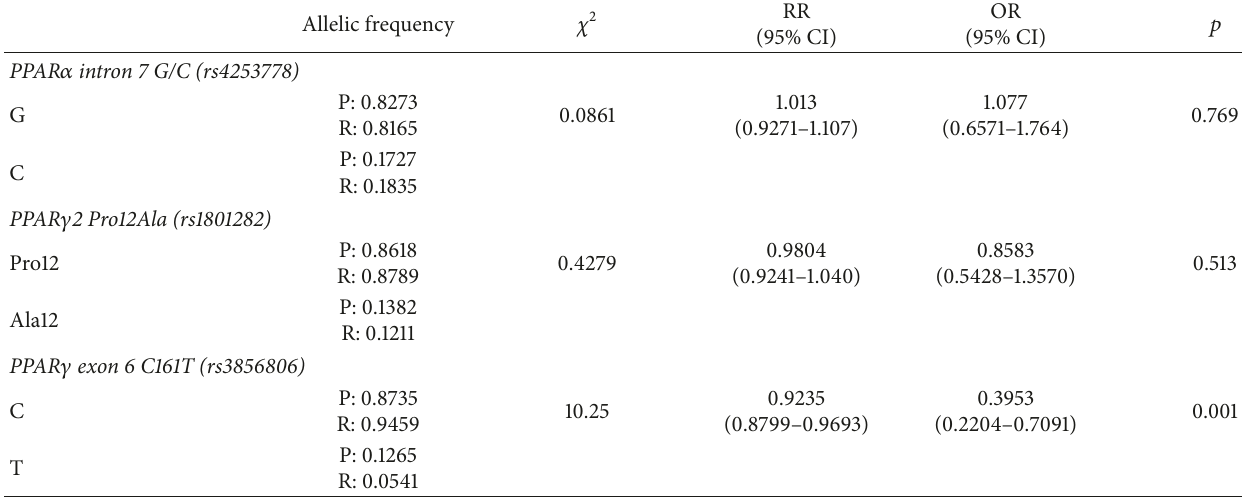
Table2:ThePPAR 𝛼 intron7G/C,PPAR 𝛾 2Pro12Ala,andPPAR 𝛾 exon6C161Talleledistributionamongpostinfarctionpatientsandreference